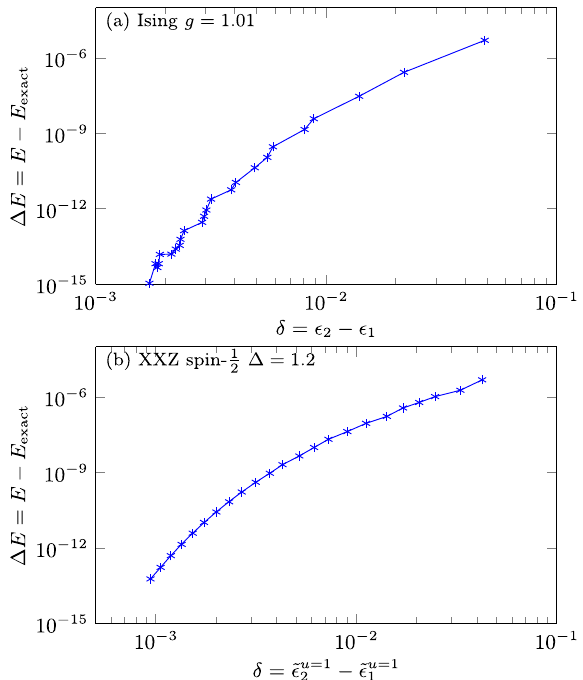
FIG. 12. The refinement parameter δ introduced in this article is not suited for extrapolation of local quantities, such as energy. This is illustrated using the example of (a) Ising model and (b) XXZ spin- 1 = 2 model, where we show the error of ground state energy Δ E converged for different D . In (a), D ¼ 8 – 100 and in (b) D ¼ 32 – 1448 . This implies that the methods which do work well for the extrapolation of the energy would not work for the correlation